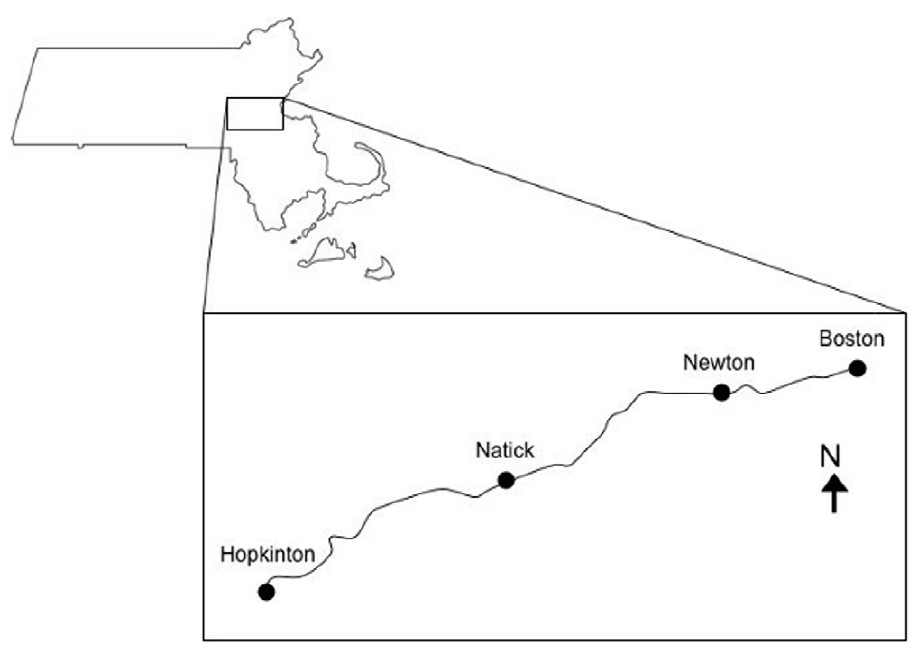
Figure 1. Map of the course of the Boston Marathon. The course runs 42.2 km from Hopkinton to Boston, Massachusetts.